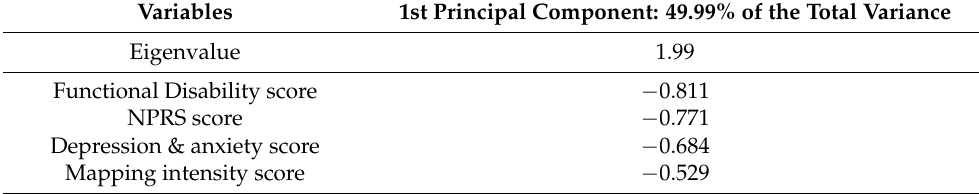
Table 5. Composition of the first principal component.